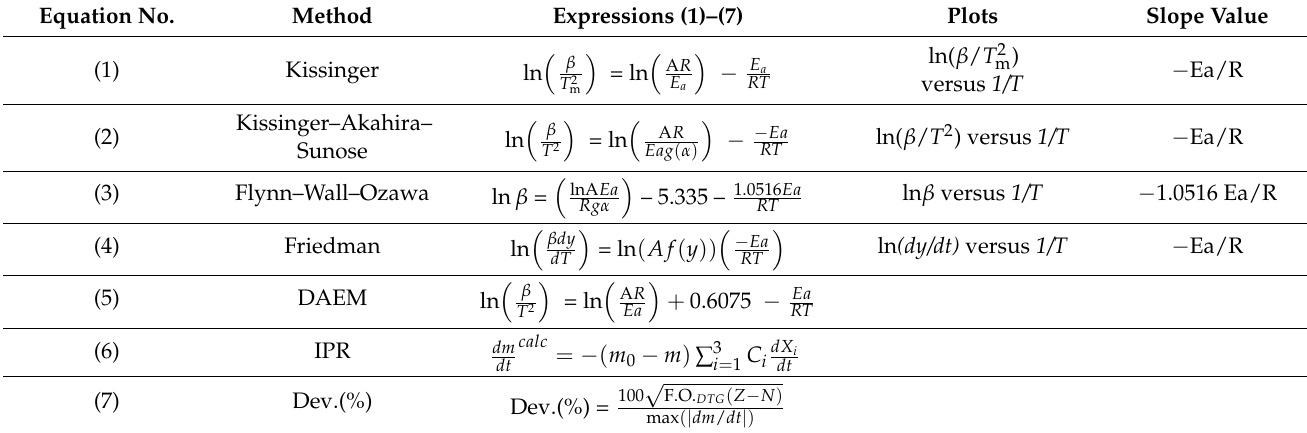
Table 1. Methods used to determine kinetic parameters for pyrolysis of metallised food packaging plastics waste (MFPW) [31,32]. Equation